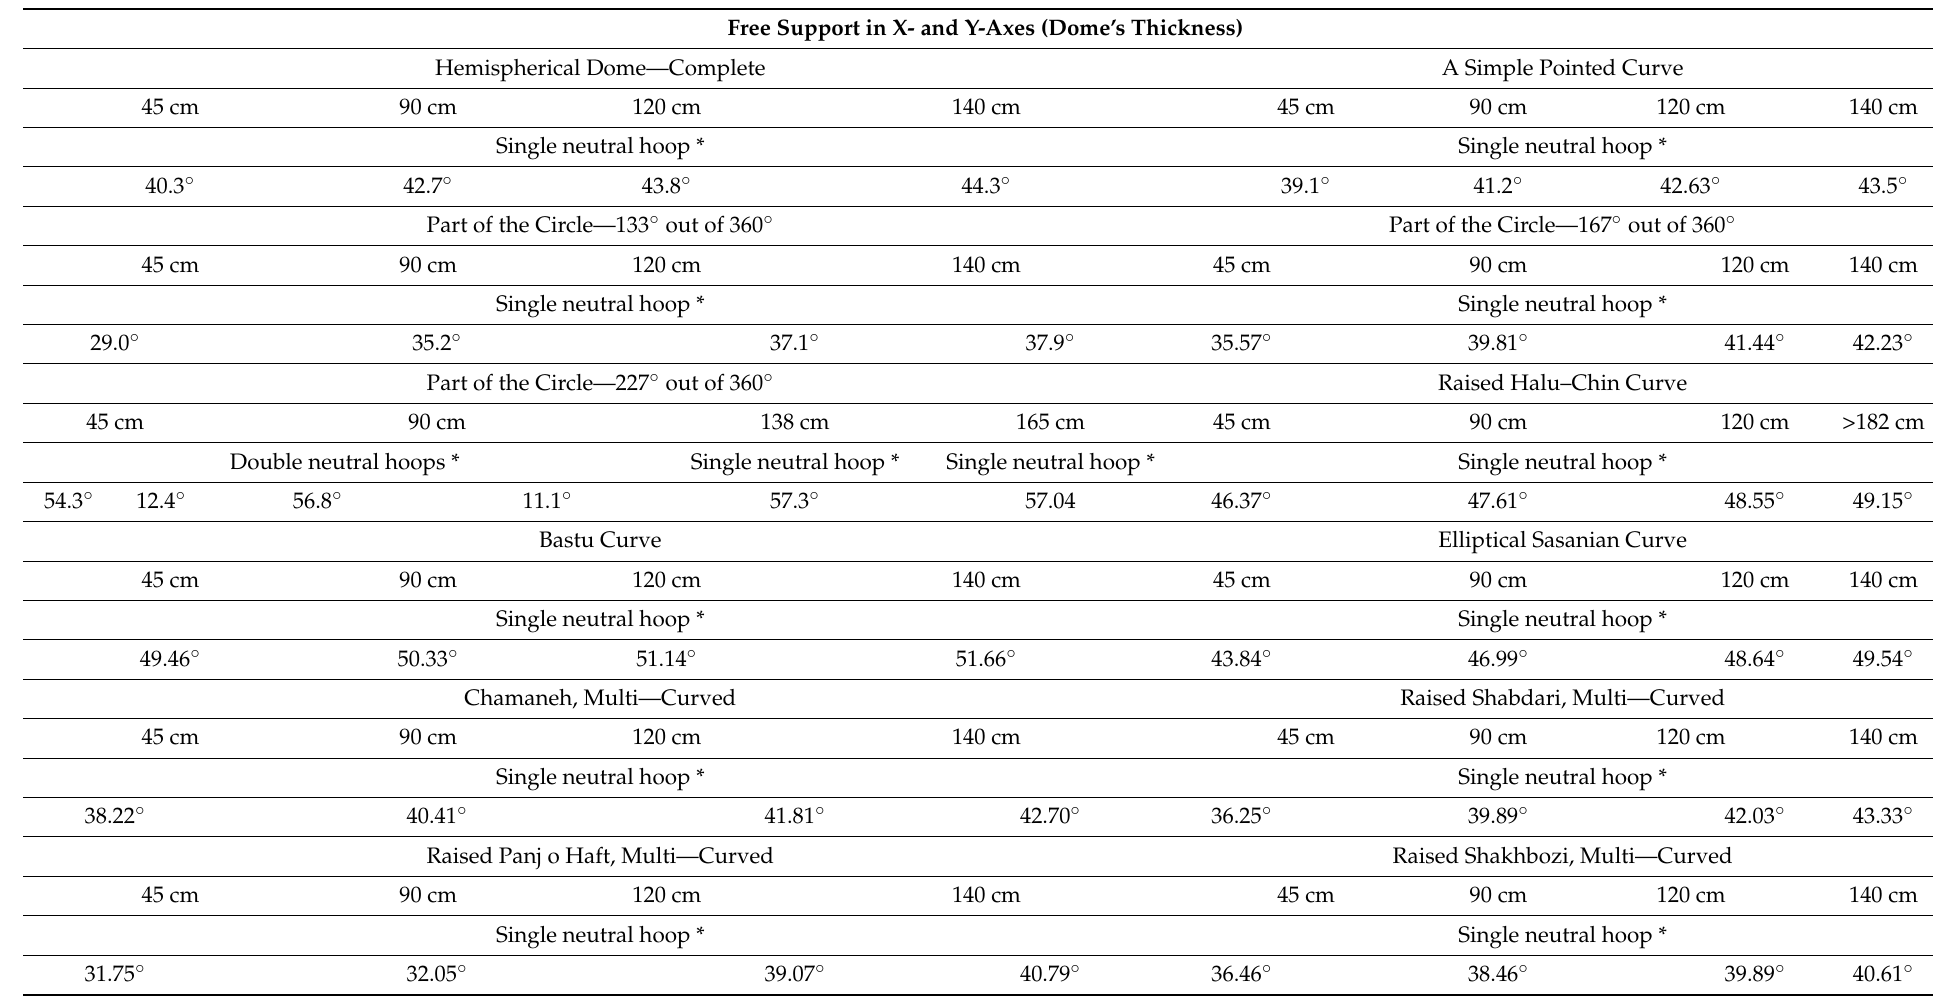
Table 7. Analysis of domes with free support in X- and Y-axes and various thicknesses—R m = 5 m. Free Support in X- and Y-Axes (Dome’s